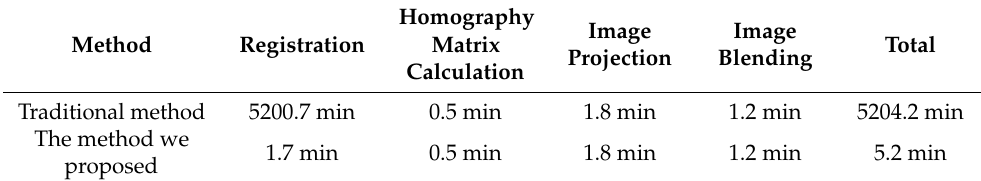
Table 4. Time of each processing stage.